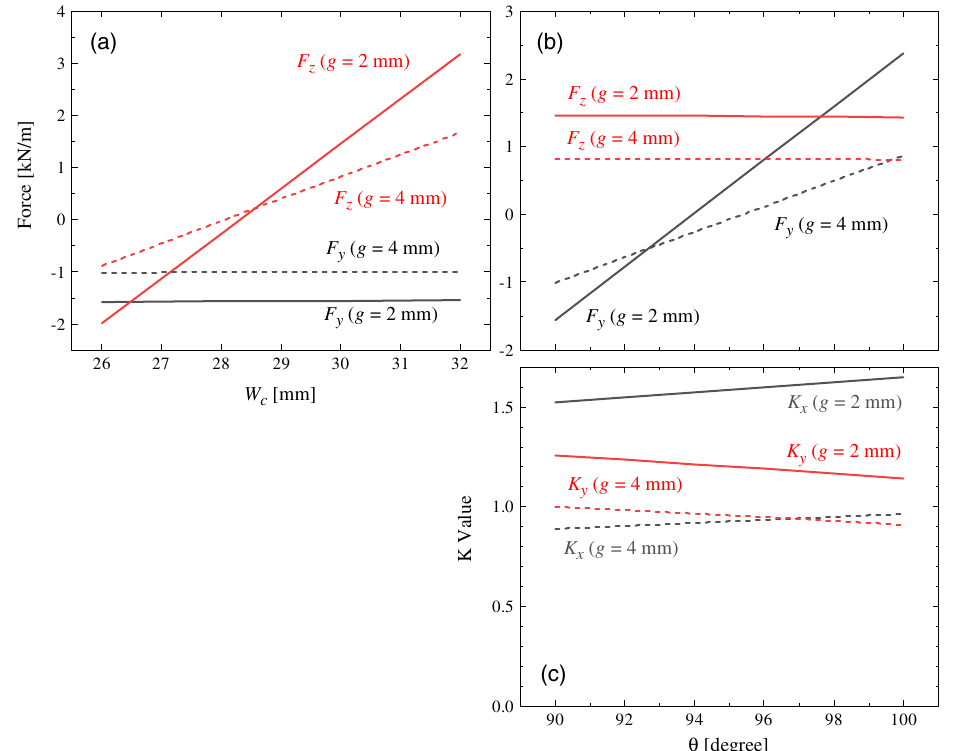
FIG. 6. Results of numerical calculation carried out to demonstrate the performance of the SPIN undulator: (a) and (b) magnetic force vs W and Δ θ , and (c) K values vs Δ θ c